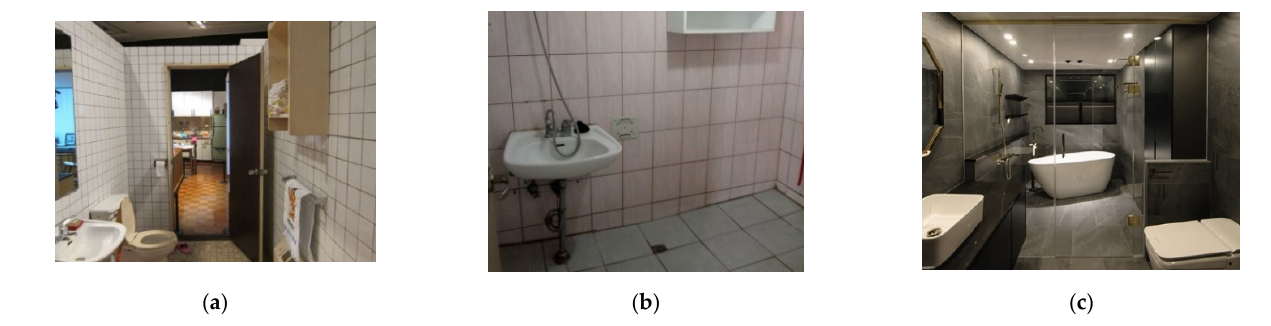
Figure 3. Facilities installed with tiles: ( a ) 1980s case; ( b ) 1990s case; ( c ) recent case.